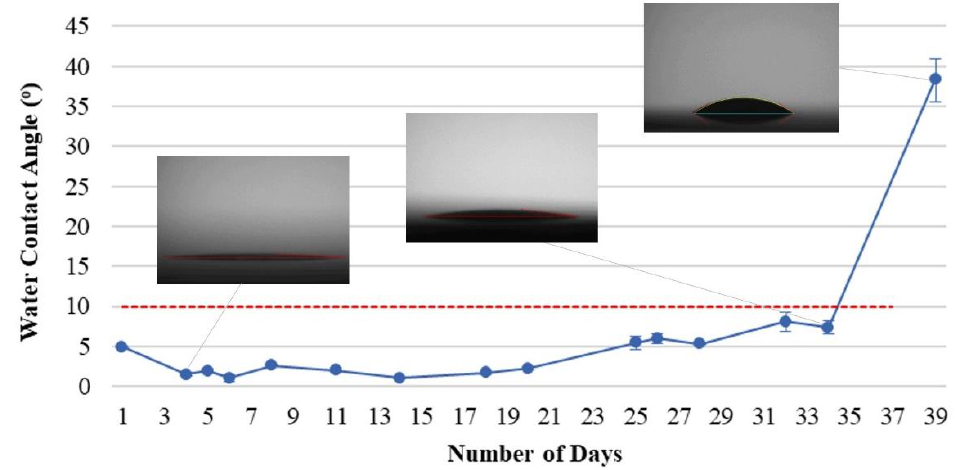
Figure 6. Hydrophilicity persistence of all-treatment PC.